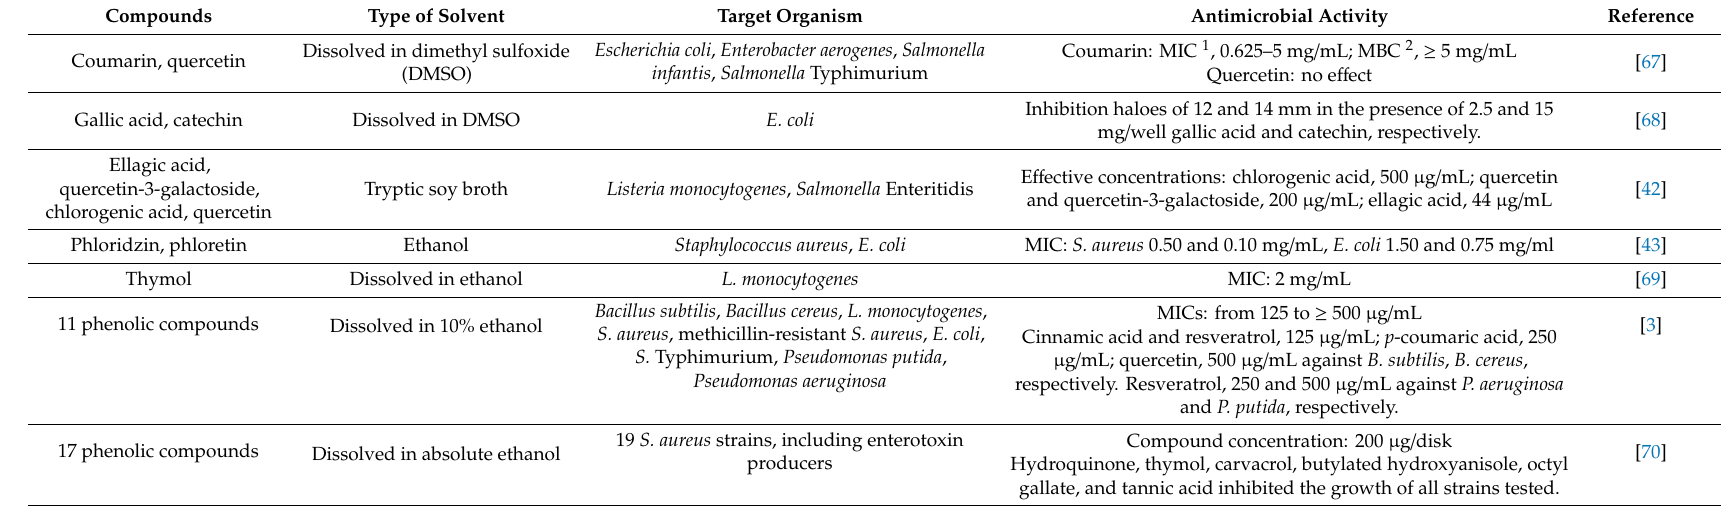
Table 3. Antimicrobial activity of individual phenolic compounds, some